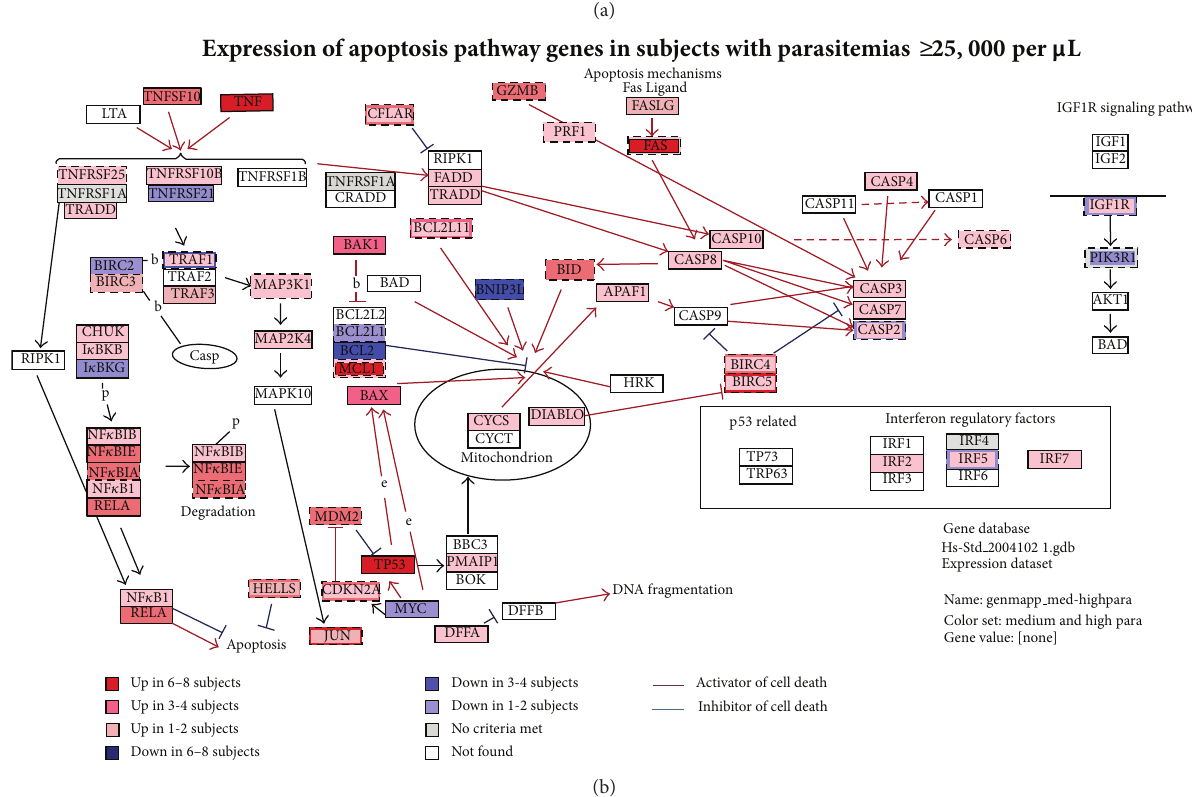
Figure 4: Apoptosis response pathway. Expression of most apoptosis-related genes correlated with the parasitemia. Note that the majority of these genes, including Fas (first apoptosis signal), FasL (Fas Ligand), and TP53 (tumor protein 53), were upregulated in subjects with medium to high parasitemias. In contrast, the BCL2 interacting protein (BNIP) family gene and the BCL2 and BCL2L1 apoptosis inhibitory genes were upregulated in subjects with low parasitemias and downregulated in subjects with medium to high